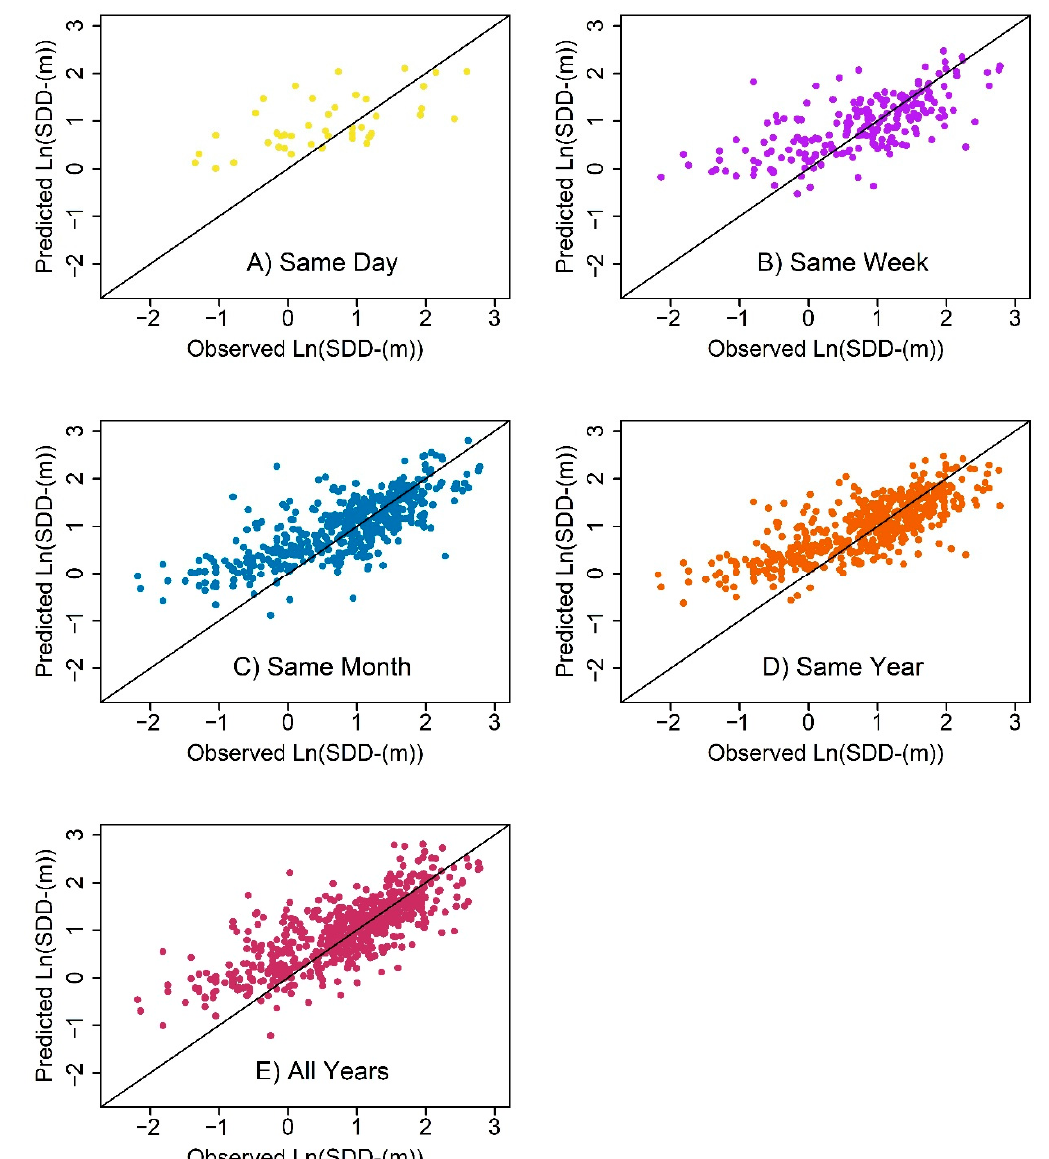
Figure 8. Predicted versus observed plot for SDD regression time window models: ( A ) SDD versus median Blue/Red within a 1-day window, ( B ) SDD versus median Blue/Red within a 7-day window, ( C ) median SDD versus median Blue/Red within a 30-day window, ( D ) median SDD versus median Blue/Red within a single season, and ( E ) median SDD versus median Blue/Red over the entire Landsat 8 record (2013–2019). Points represent the mean predicted value to the observed value for the validation dataset (Lake Pulse data). Diagonal lines represent the 1:1 line.